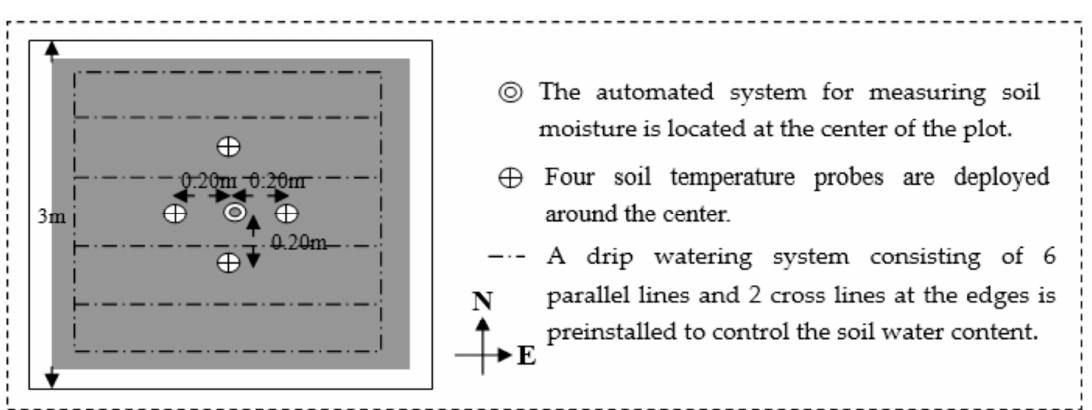
Figure A2. The deployment of instruments at each plot.